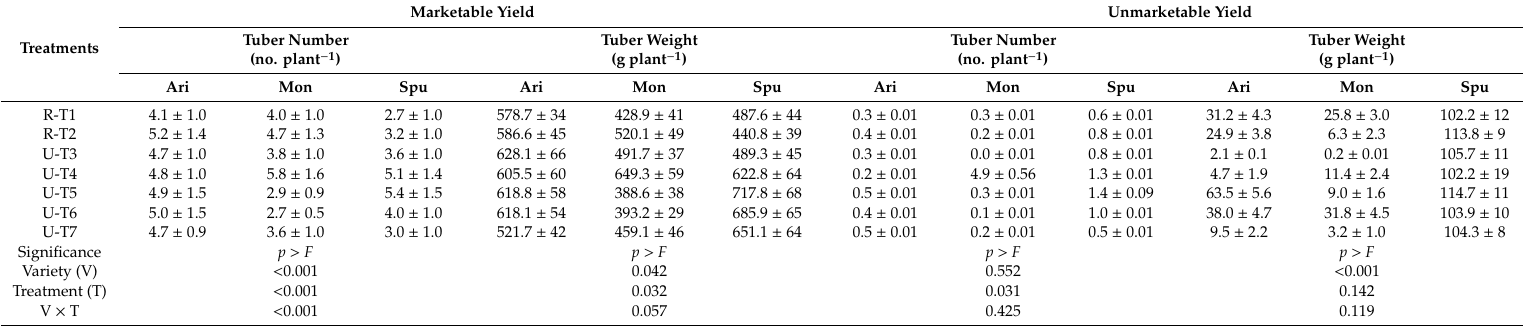
Table 12. Average ( ± standard error) marketable and unmarketable plant production (expressed as number and grams of tuber per plant) of three varieties subjected to seven dormancy-breaking treatments in the 2000 growing season (Experiment